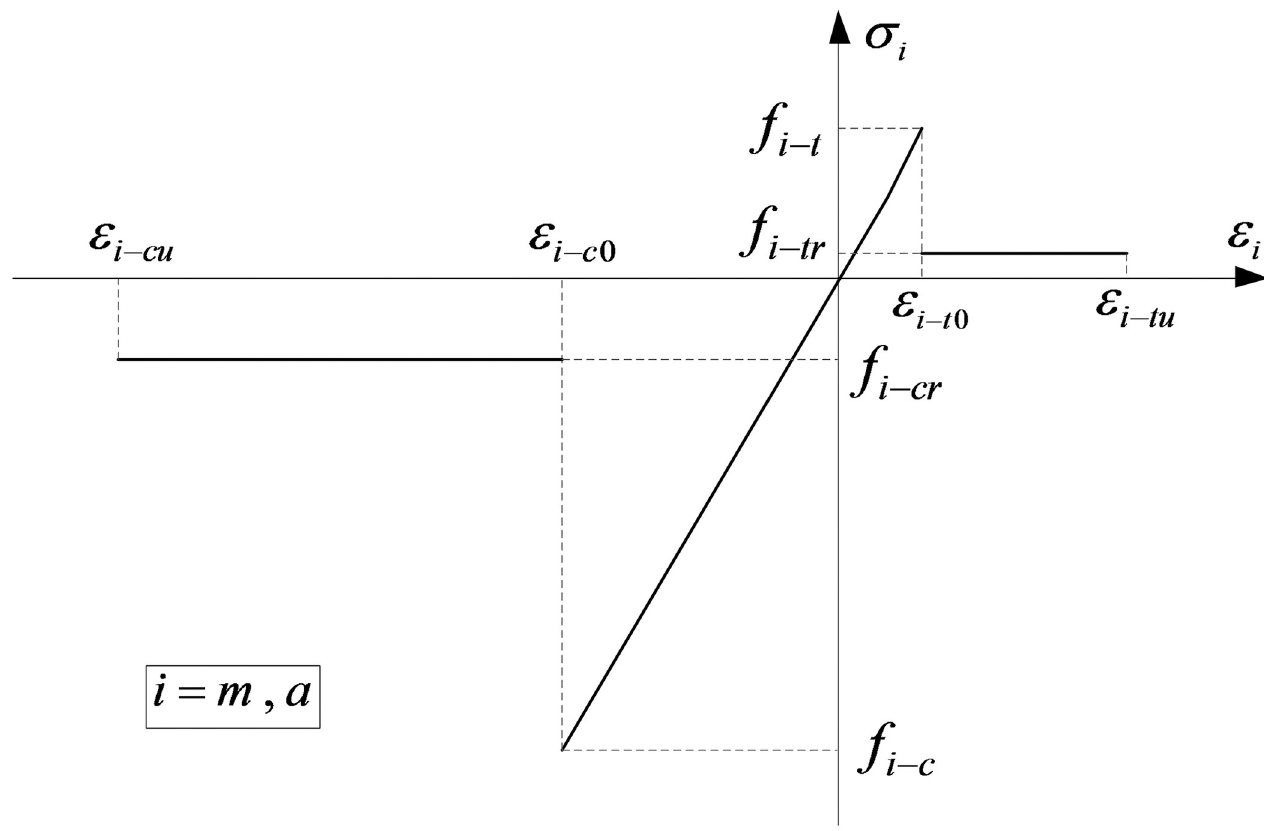
Fig 3. Constitutive relation of mortar and coarse aggregate [28]. ε i − t 0 is the tensile strain threshold for damage evolution and ε i − tu is the tensile strain limit. f i − t is the uniaxial tensile strength and f i − tr is the residual tensile strength after damage initiation. ε i − c 0 is the compressive strain threshold and ε i − cu is the compressive strain limit. f i − c is the uniaxial compressive strength and f i − cr is the residual compressive strength after damage initiation.